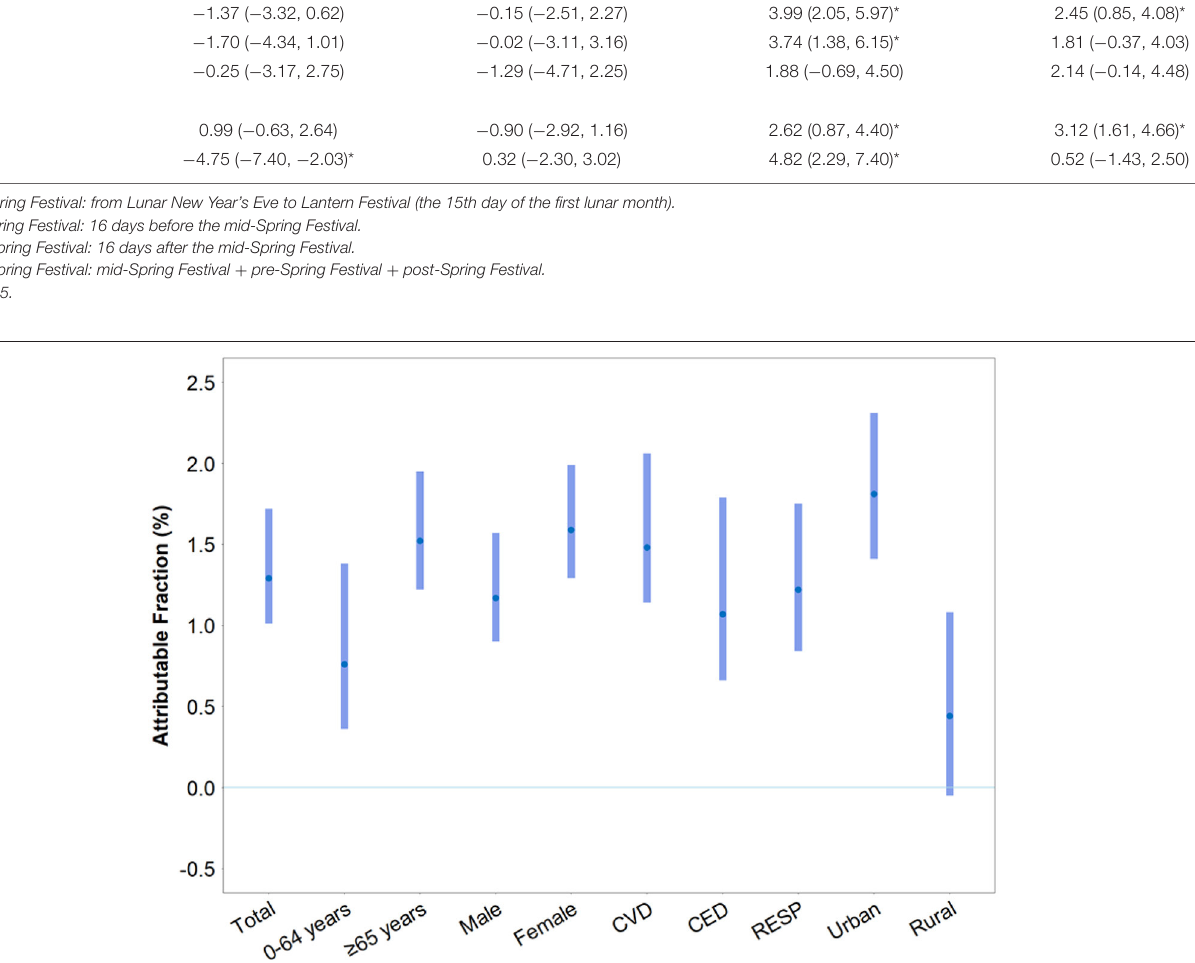
Figure 3 displayed the AF of mortality caused by the different phases of the Spring Festival. In total, 1.29% (95%CI: 1.01%, 1.72%) mortality was attributed to the Spring Festival effect.